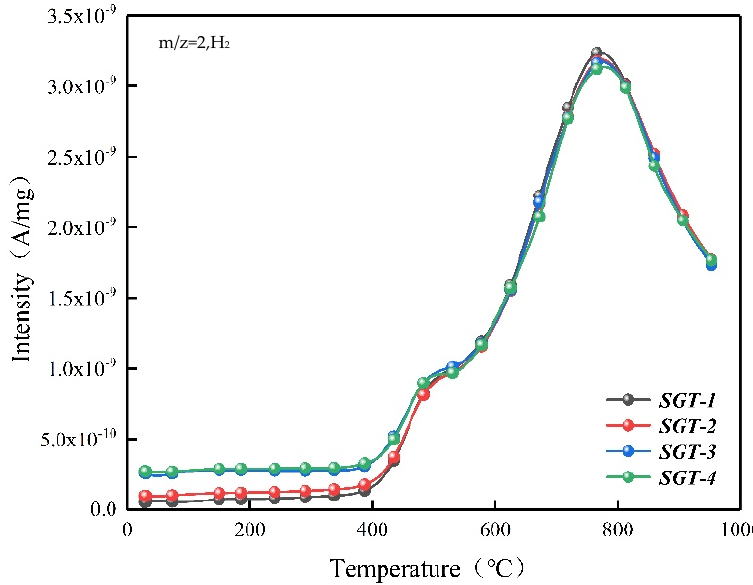
Figure 7. Evolution curves of H 2.